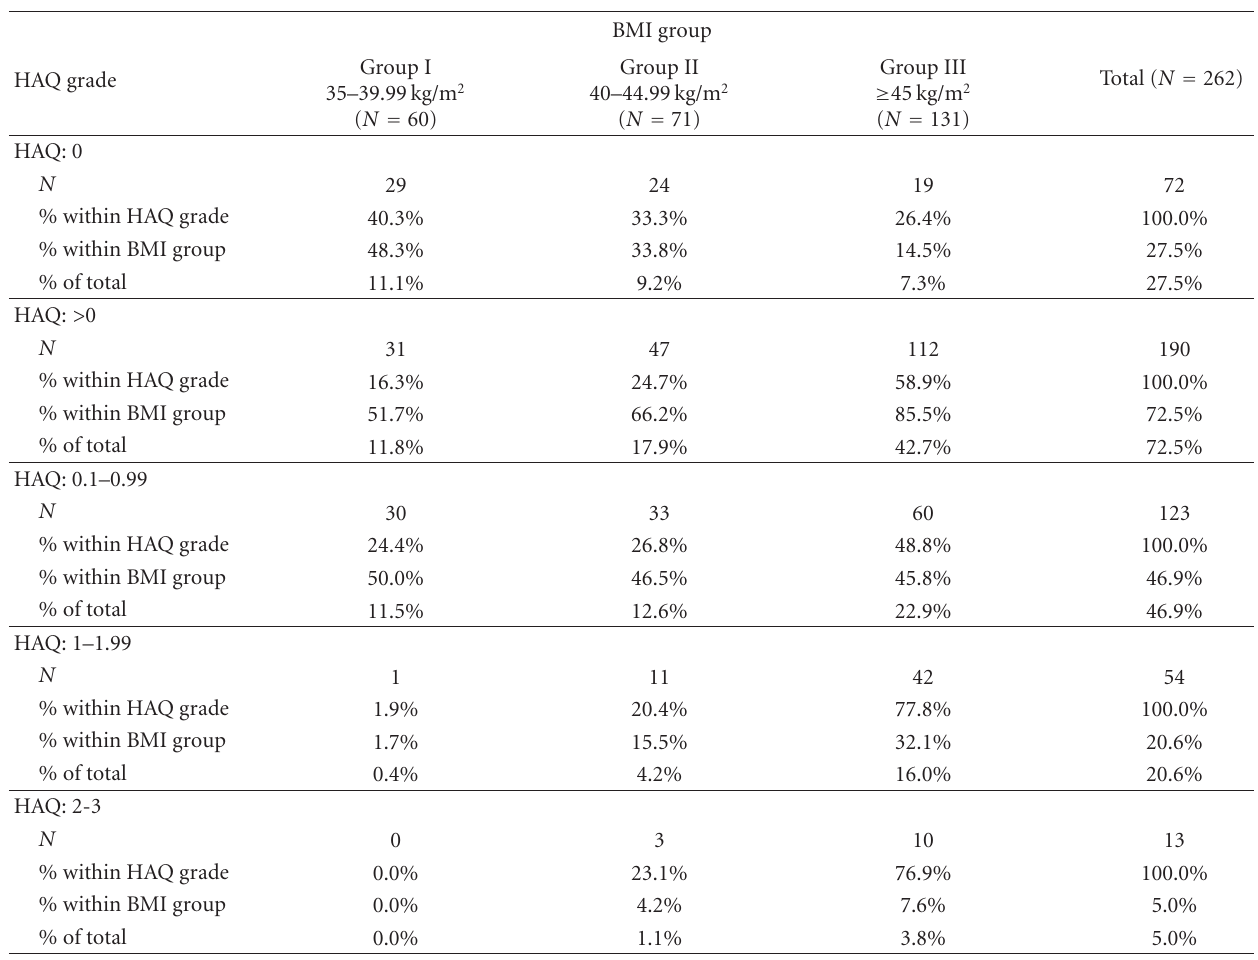
Table 3: Prevalence rates of degrees of disability based on the Health Assessment Questionnaire (HAQ) score across the three body mass index (BMI) study groups (no disability (HAQ score: 0); at least some degree of disability (HAQ score > 0); mild to moderate di ffi culty in performing daily life activities (HAQ score: 0.1–0.99); moderate to severe disability (HAQ score: 1–1.99); severe to very severe disability (HAQ score: